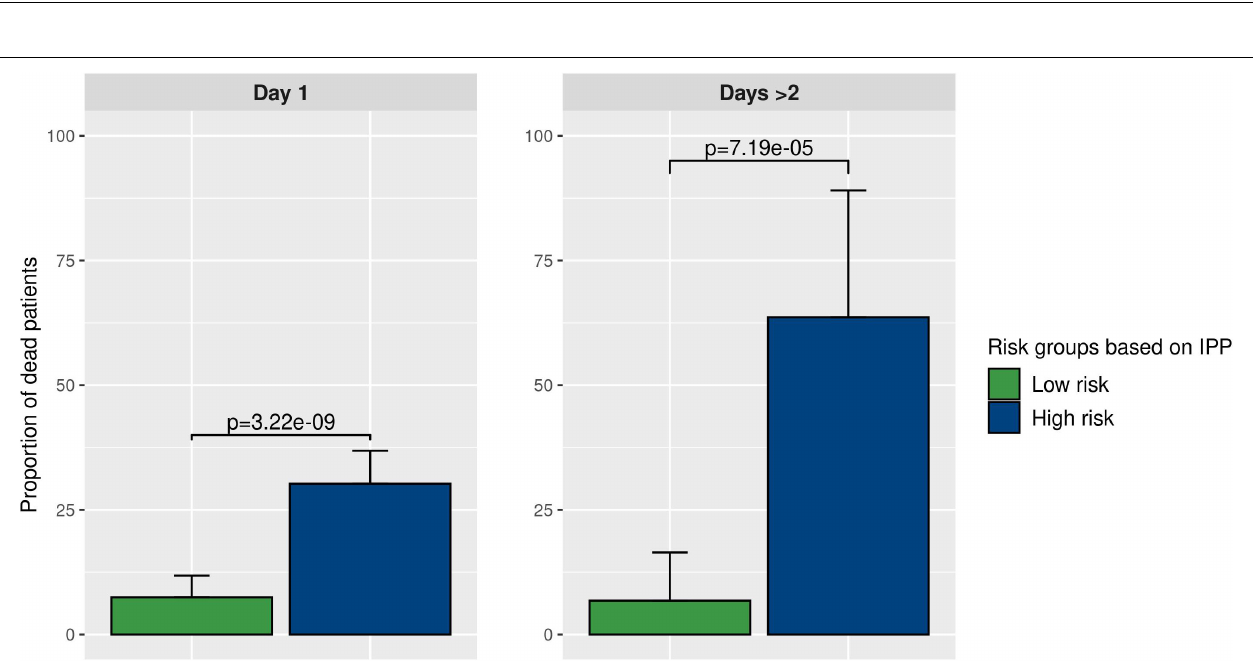
FIGURE 5 | Prognostic enrichment with the IPP tool. We used the best IPP models (trained on the “day 1” and “days > 2” discovery sets) and computed a test threshold using the top-left method on corresponding validation sets. This enabled us to divide the validation sets in 2 sub-groups with a low and a high predicted risk of death. Then, we compared the actual proportion of sepsis patients deceased at day 30 in both sub-groups, to assess if IPP could be used for prognostic enrichment at the bedside.